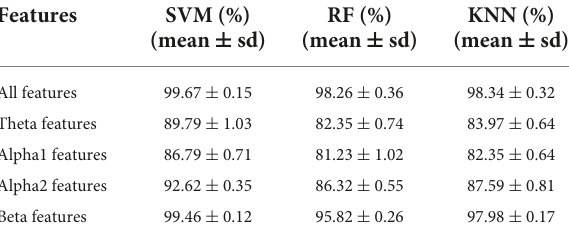
TABLE 4 Classification accuracies with different rhythms between Young_GAD and Old_GAD.